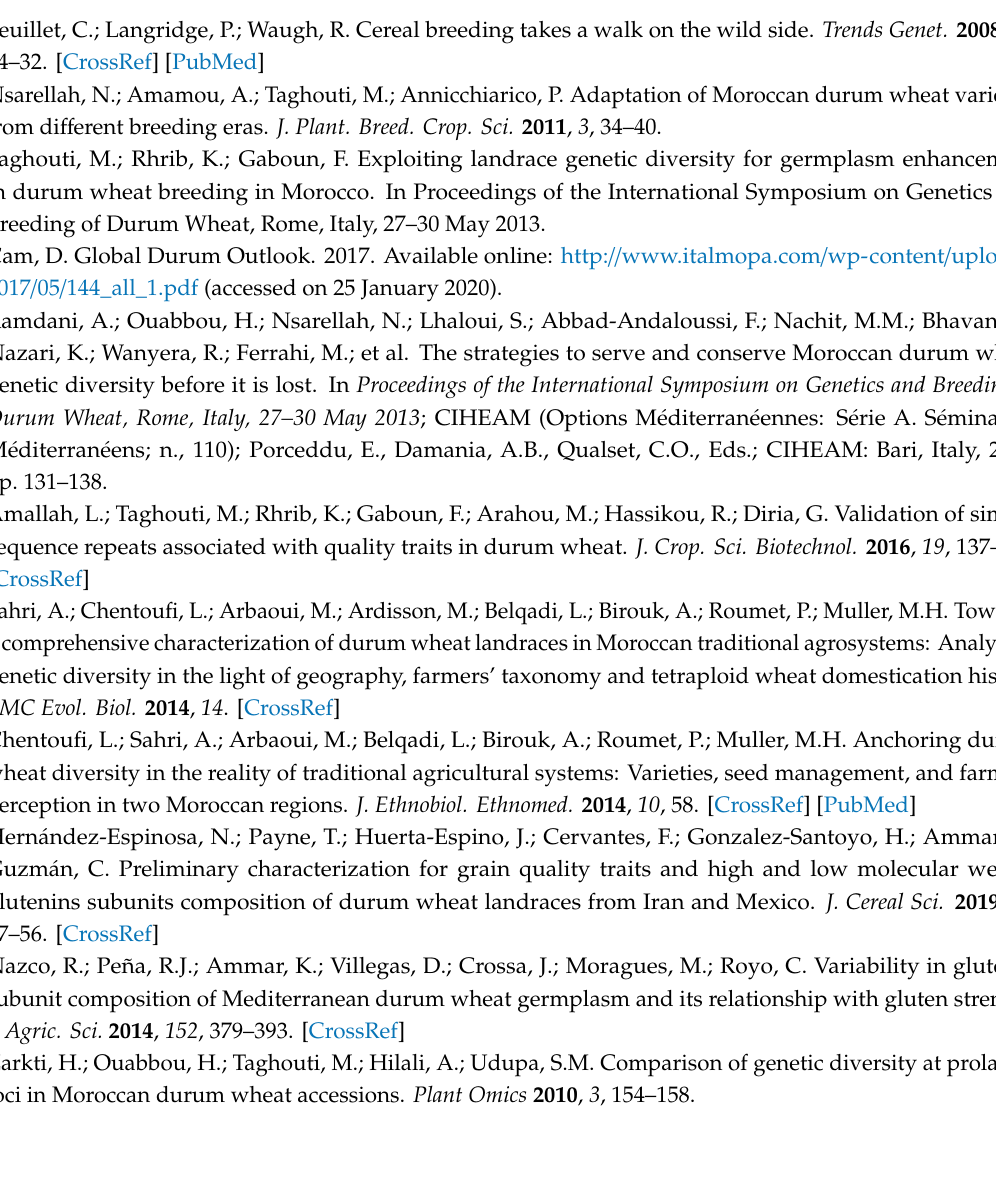
Electronic Supplementary Table S1: Glutenins composition of 95 durum wheat accessions of the Moroccan Germplasm